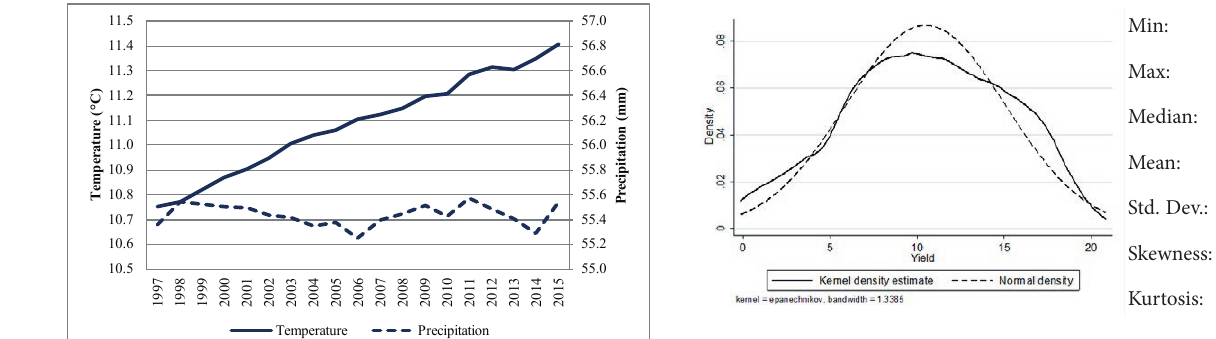
Figure 3. Distribution and descriptive statistics for